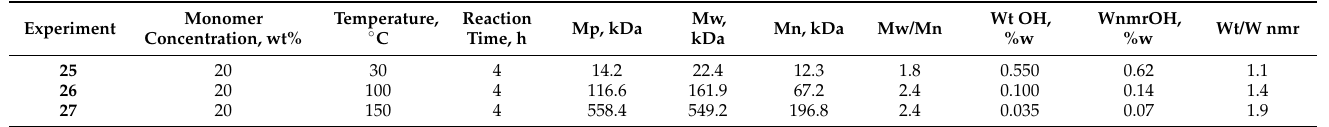
Figure 10. GPC curves obtained in Experiments 25 – 27 . Table 4. Molecular weight characteristics of polymers 25 – 27